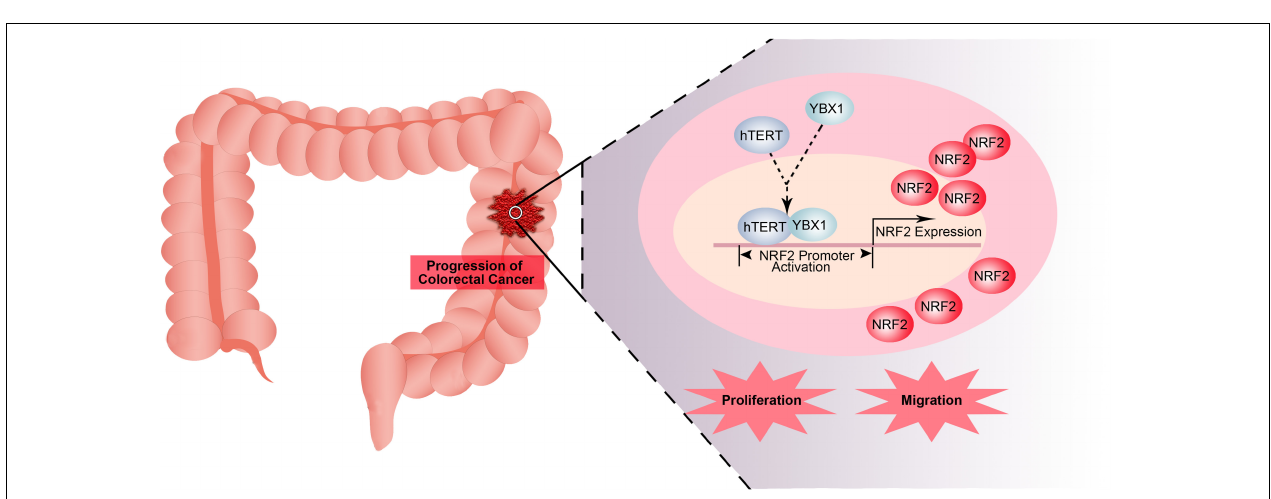
FIGURE 7 | Model for transcriptional regulation of NRF2 by hTERT via recruitment of YBX1 in CRC proliferation and migration. In this model, hTERT recruits YBX1 to form a transcriptional complex, which binds to the NRF2 promoter to promote NRF2 expression, thus promoting CRC proliferation and